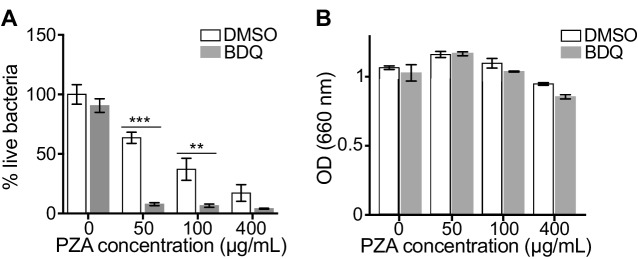
BDQ potentiates PZA antimycobacterial activity.(A) Macrophages were infected with BDQr-MTB and treated with BDQ (1 μg/mL) and PZA. After 7 of days treatment, cells were lysed and bacteria were enumerated by CFU (counted in triplicate). (B) Optical density (OD) measurements of bacterial growth of BDQr-MTB in the presence of BDQ (1 μg/mL) and different concentrations of PZA. Bacteria were cultured in 7H9 medium supplemented with 10% OADC enrichment with/without the drugs. One representative experiment (of at least three) is shown. Error bars represent the mean ± SD. *p<0.05, **p<0.01, ***p<0.001.